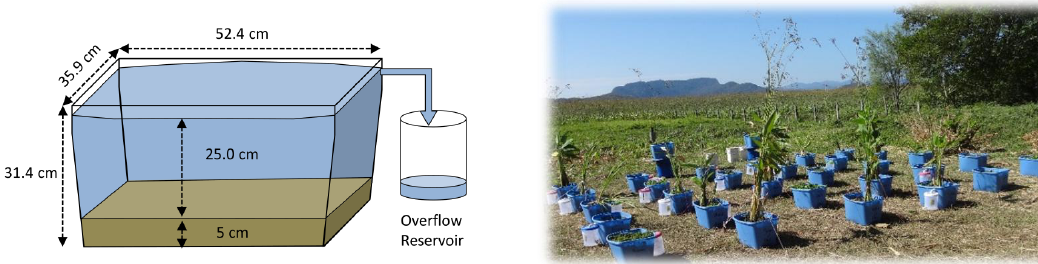
Figure 4. Lysimeter design used during the experiment ( left image) and the distribution of lysimeters ( right image) at the experimental site in Palo Verde National